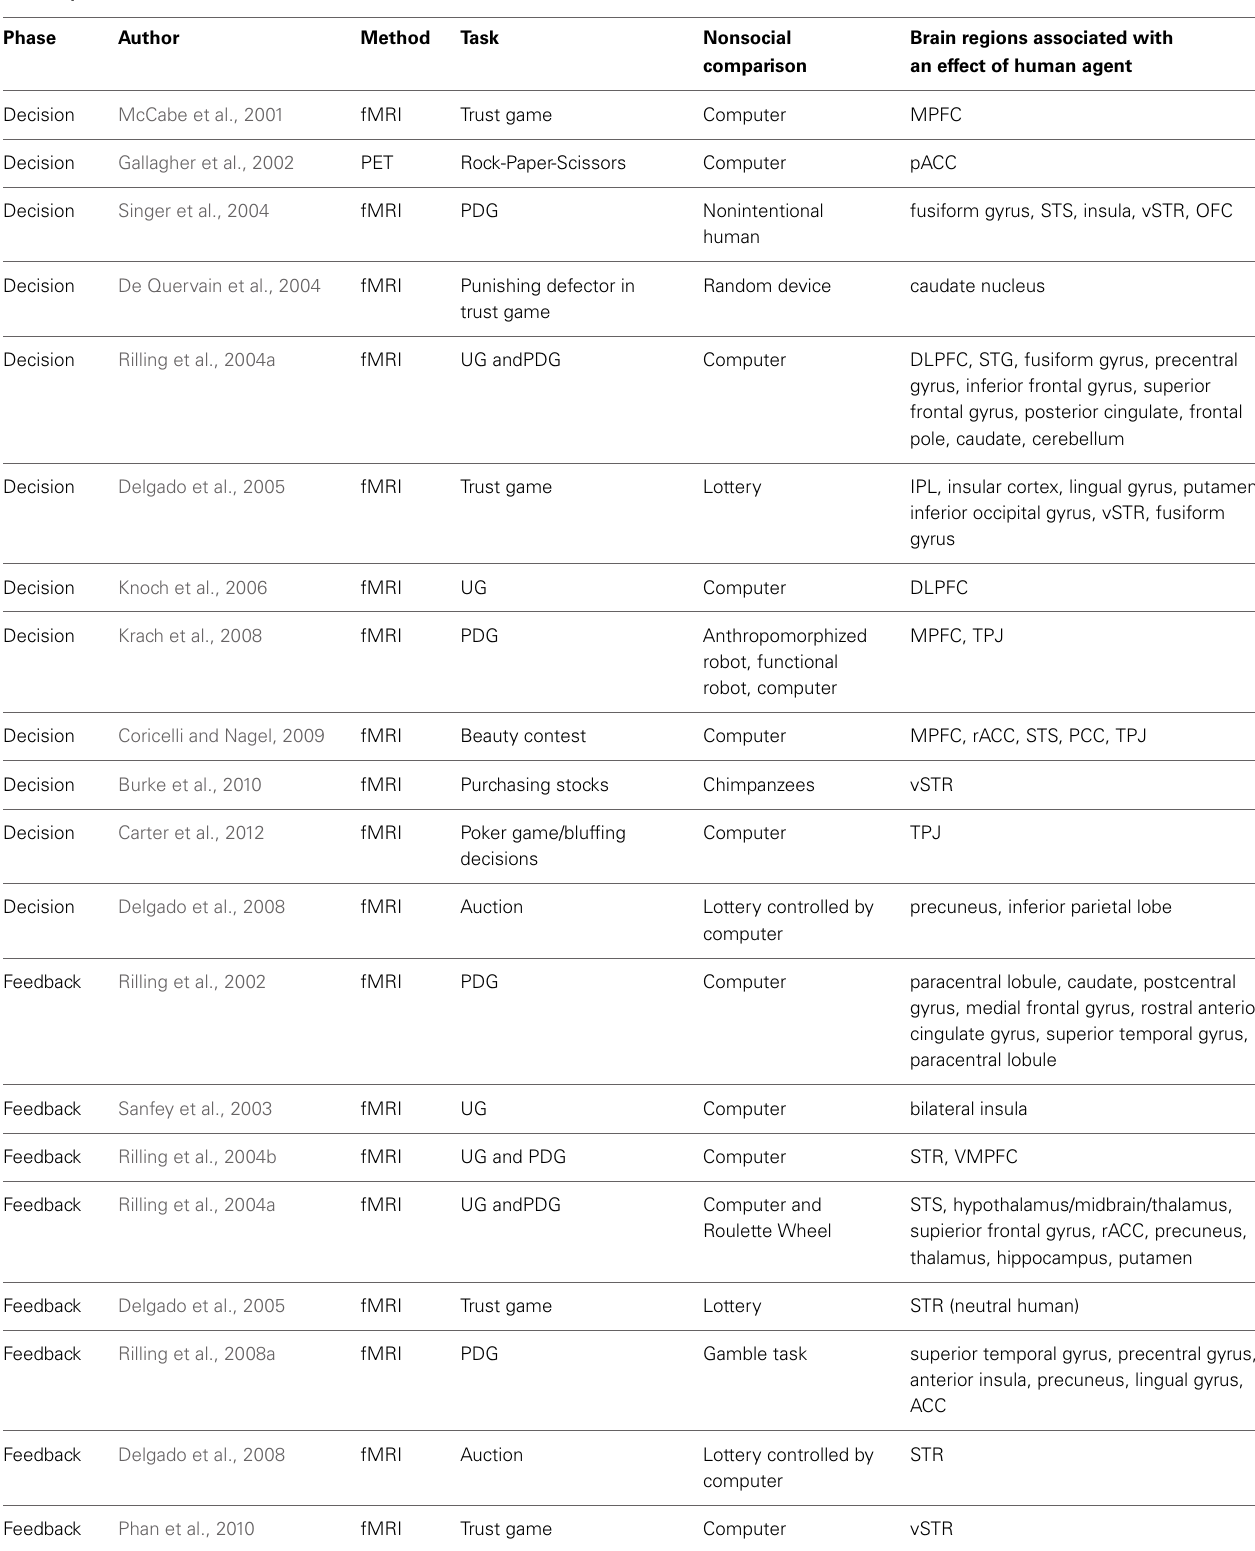
Table 1 | Summary of studies comparing human and non-social